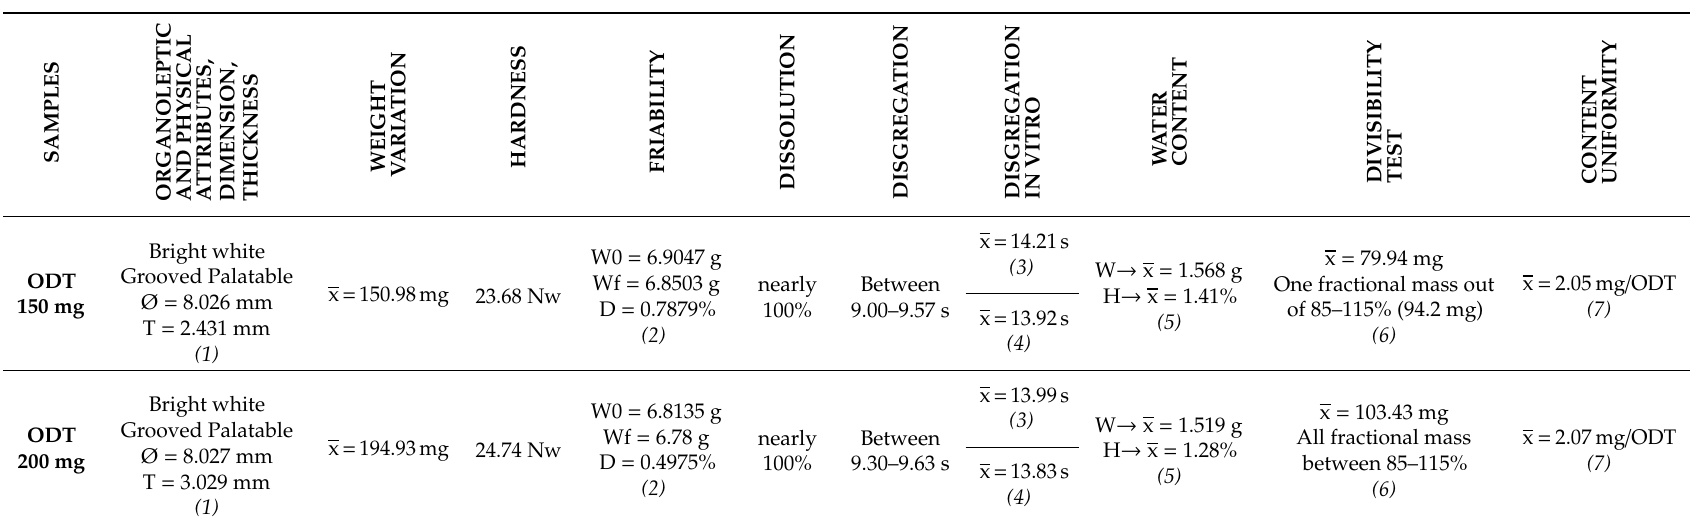
Table 4. LoperamideODT